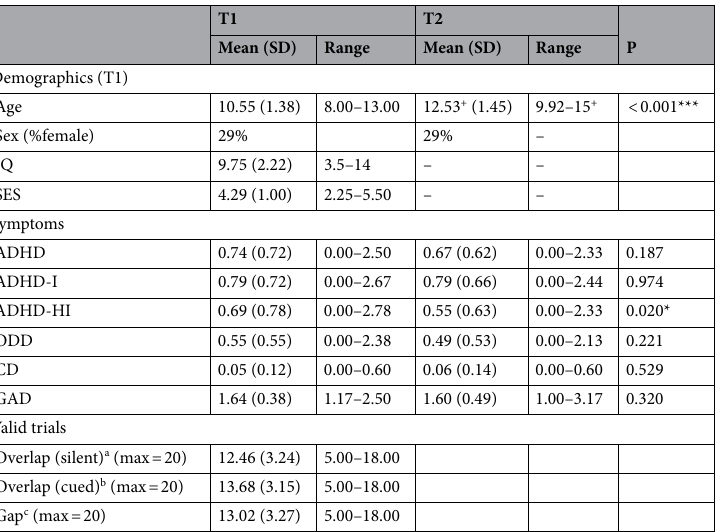
Table 1. Participants with and without valid data at T2 did not differ in age at T1 or any of the symptom measures (all p > 0.14, see Supplement, S1).